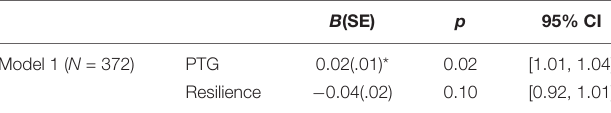
TABLE 2 | Logistic regression analysis for PTG and resilience predicting ERA